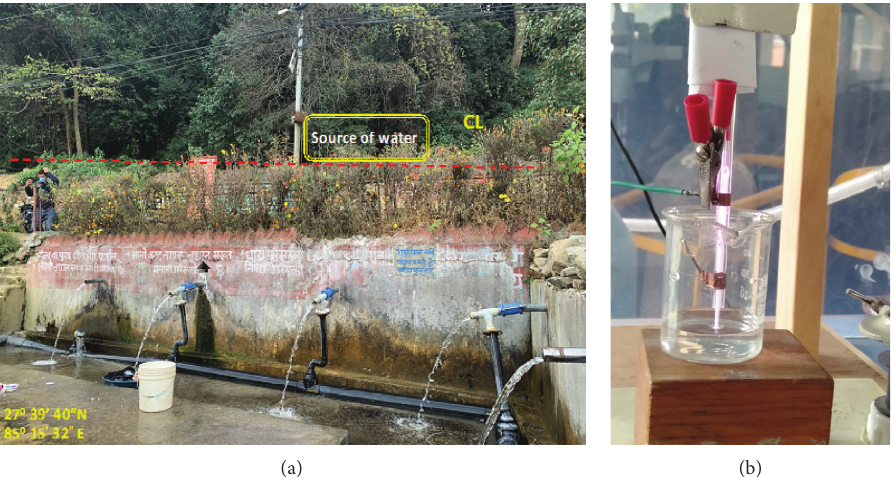
Figure 2: (a) Photograph showing a location of the Dudhpokhari tap water source; CL, Chandragiri limestone. (b) CAPJ treatment to water